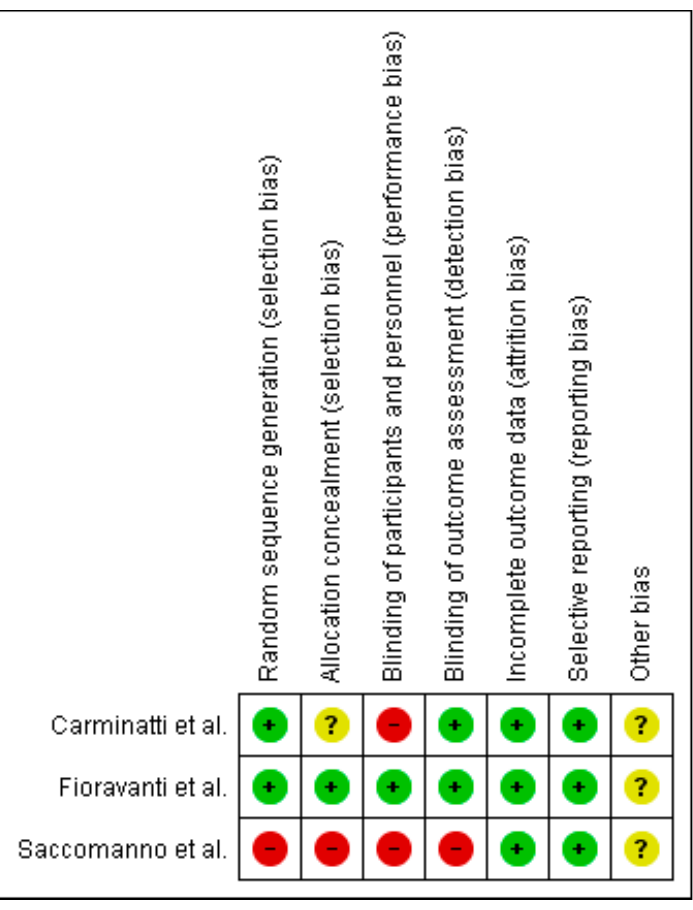
Figure 2. Risk of bias summary.